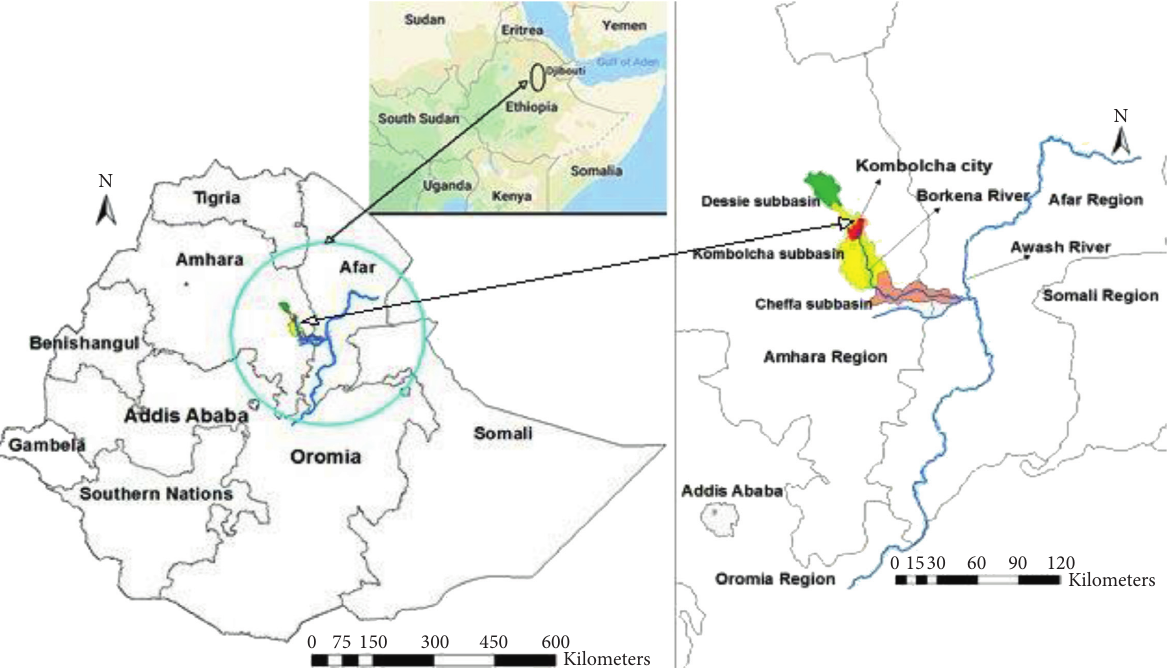
Figure 1: Location map of Kombolcha/study